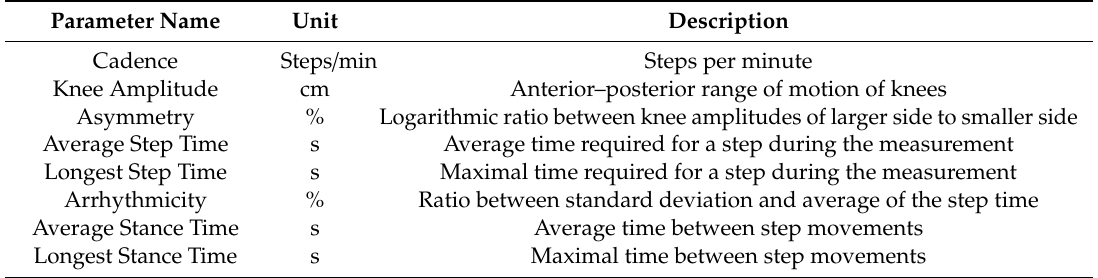
Table 2. Description of eight kinematic parameters from VPC recordings of stepping in place (SIP) task